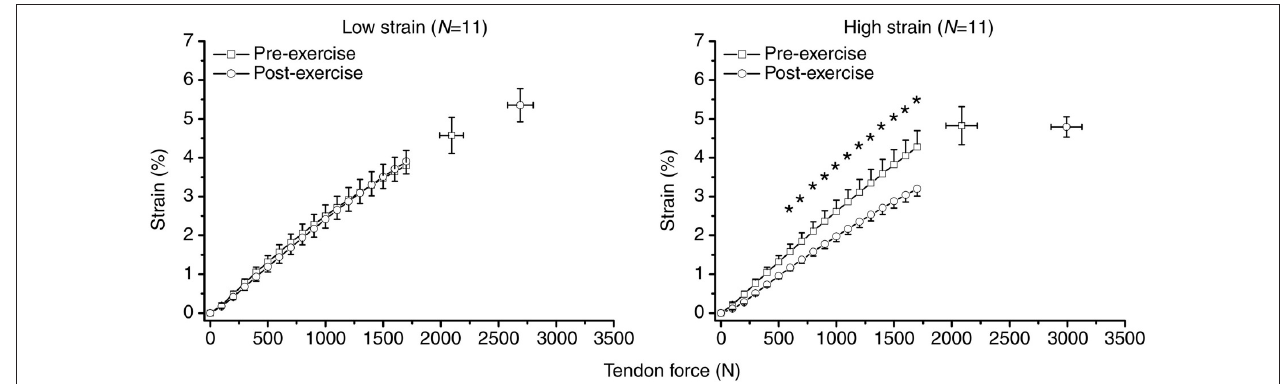
FIGURE 1 | Achilles tendon-aponeurosis force-strain relationship before and after two isometric exercise protocols. The two legs of eleven adults were subjected to either moderate [i.e., 55% maximum voluntary contraction (MVC); low strain] or high loading (90% MVC; high strain) for 14 weeks, respectively. Both protocols induced an increase of tendon force. However, following moderate loading (i.e., low strain protocol) tendon stiffness did not change significantly and, thus, there was a significant increase of tendon strain during maximum muscle contractions. This implies an increase of the mechanical demand placed upon the tendon. No change was observed in a control group (data not shown). *Significant difference between pre- and post-exercise values (Arampatzis et al., 2007, adapted with permission from The Company of Biologists